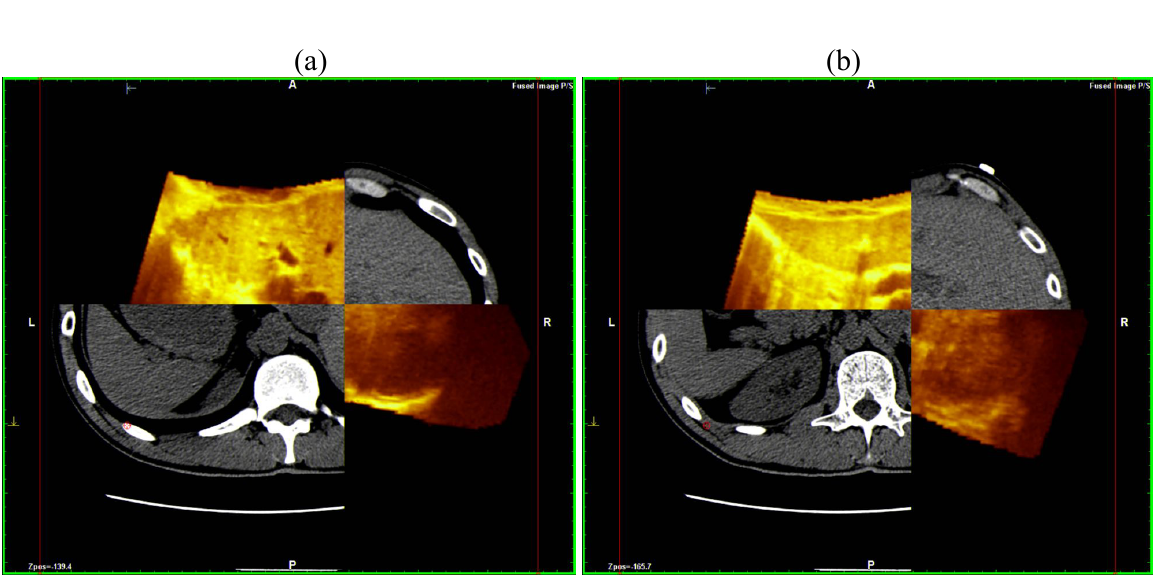
Figure 4. Fusion technique with NAVIGATOR system: Two different planes of reconstruction (( a ) and ( b )) of CT and US perfectly overlap. This system is able to separate the two planes (yellow for US, grey for CT) showing the perfect alignment of the margins with each